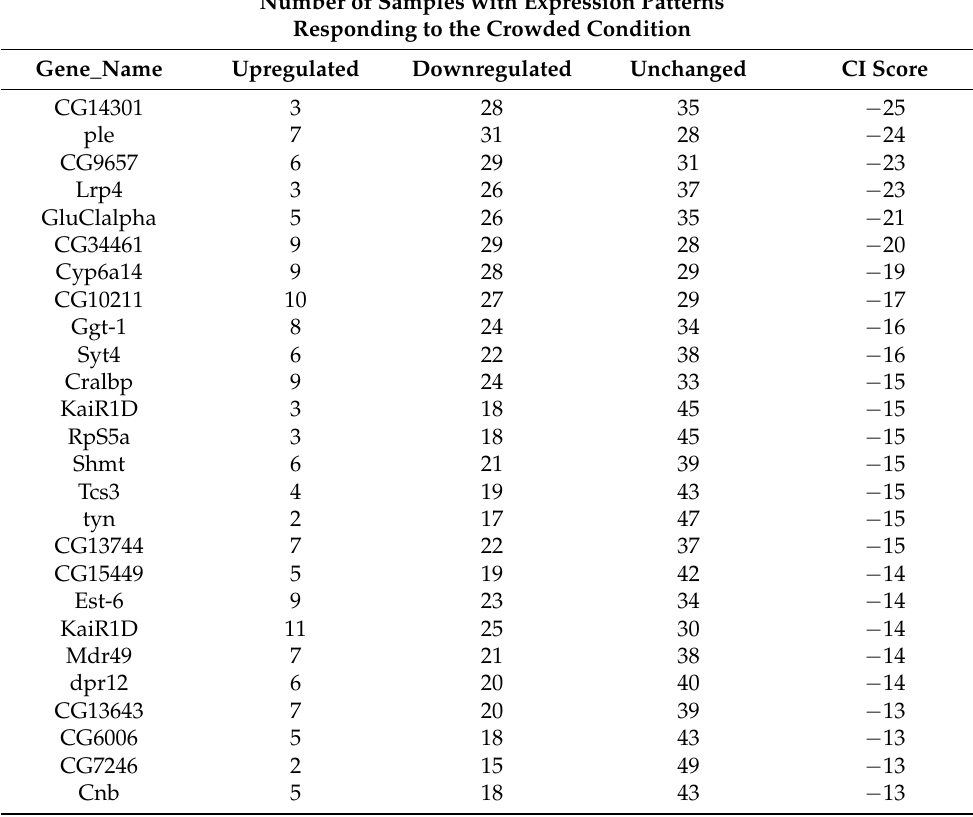
Table 3. Top 1% of genes with the lowest CI scores. Number of Samples with Expression